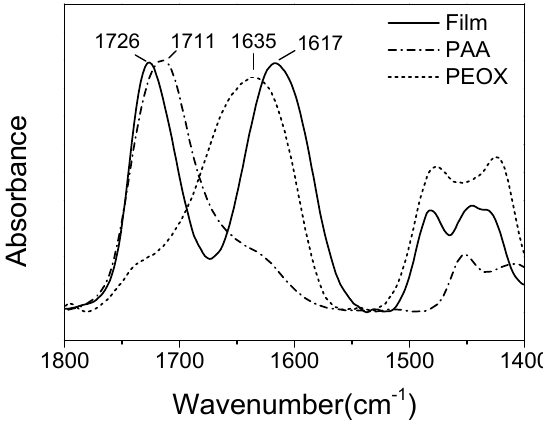
Figure 1. FT-IR spectra of PEOX, PAA and (PEOX/PAA) 20 film (PEOX, M w 50,000; PAA, M w 450,000; pH 2.0; assembling time, 4 min; rinsing time, 1 min; and room temperature).